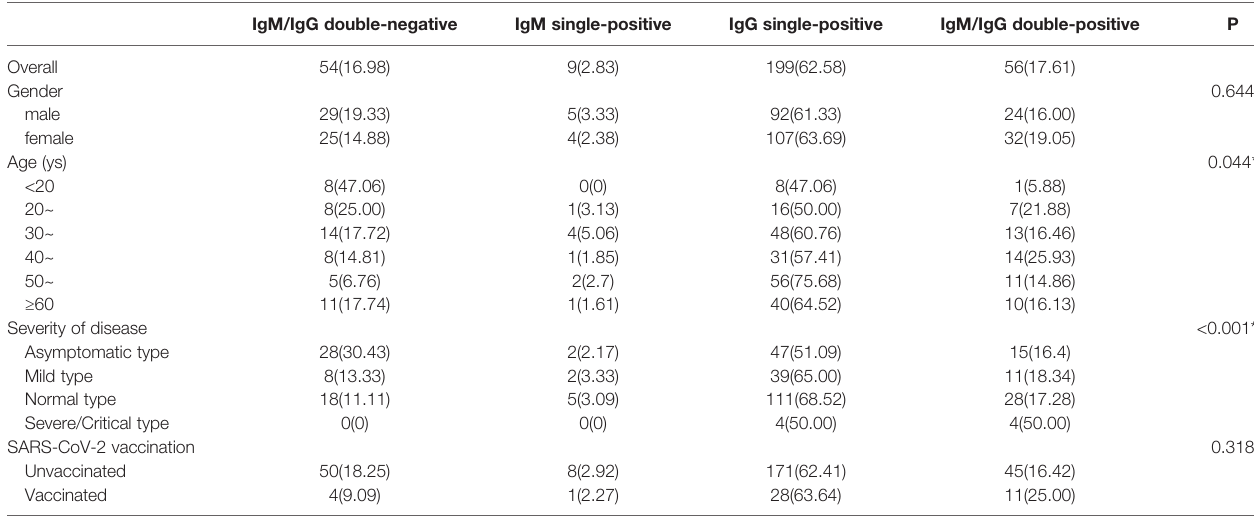
TABLE 3 | Distribution of IgM/IgG combinations in second-round follow-up